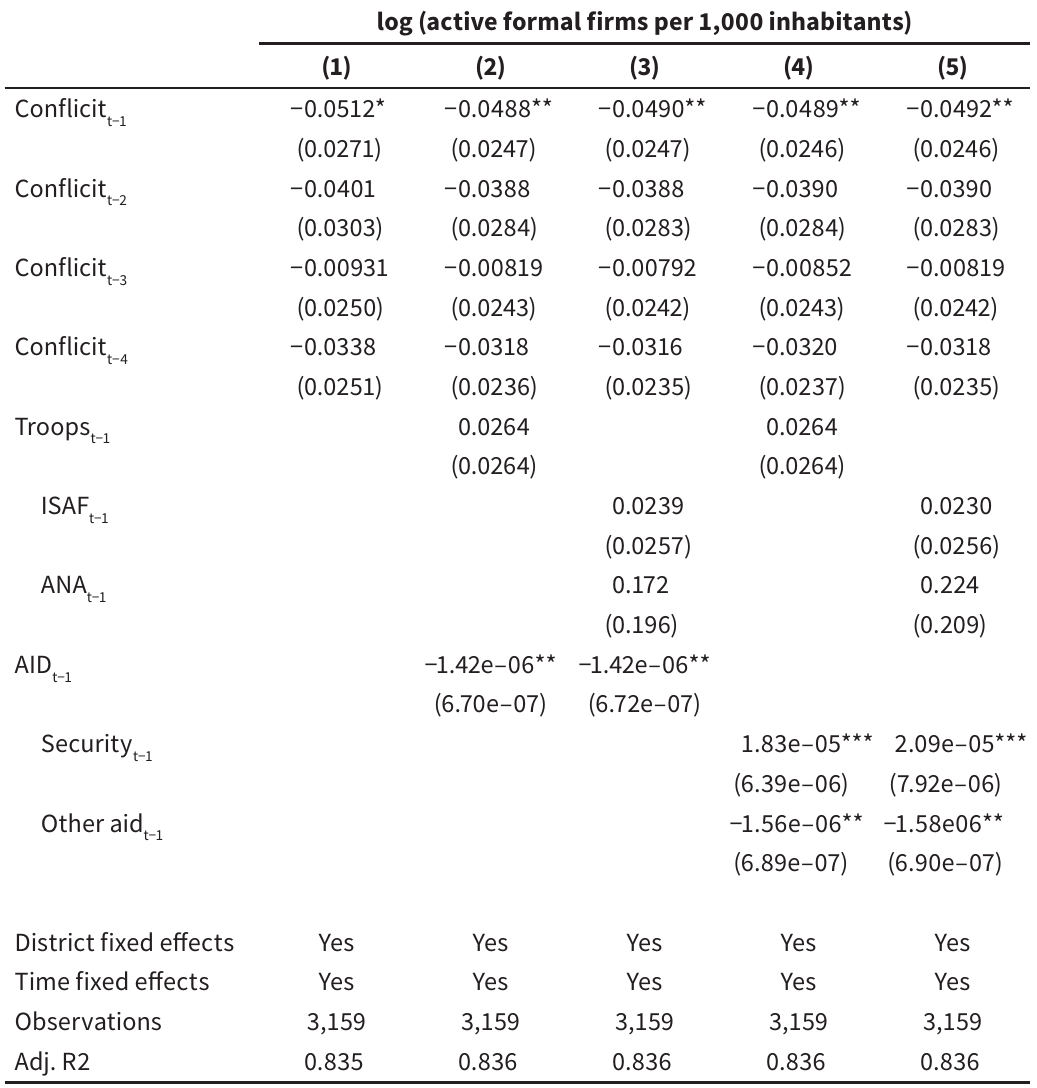
Conflict and active formal